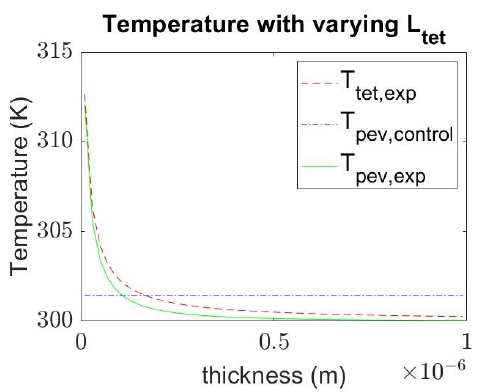
Figure 9. The temperature after the first timestep for each layer with respect to various tetracene layer thickness.